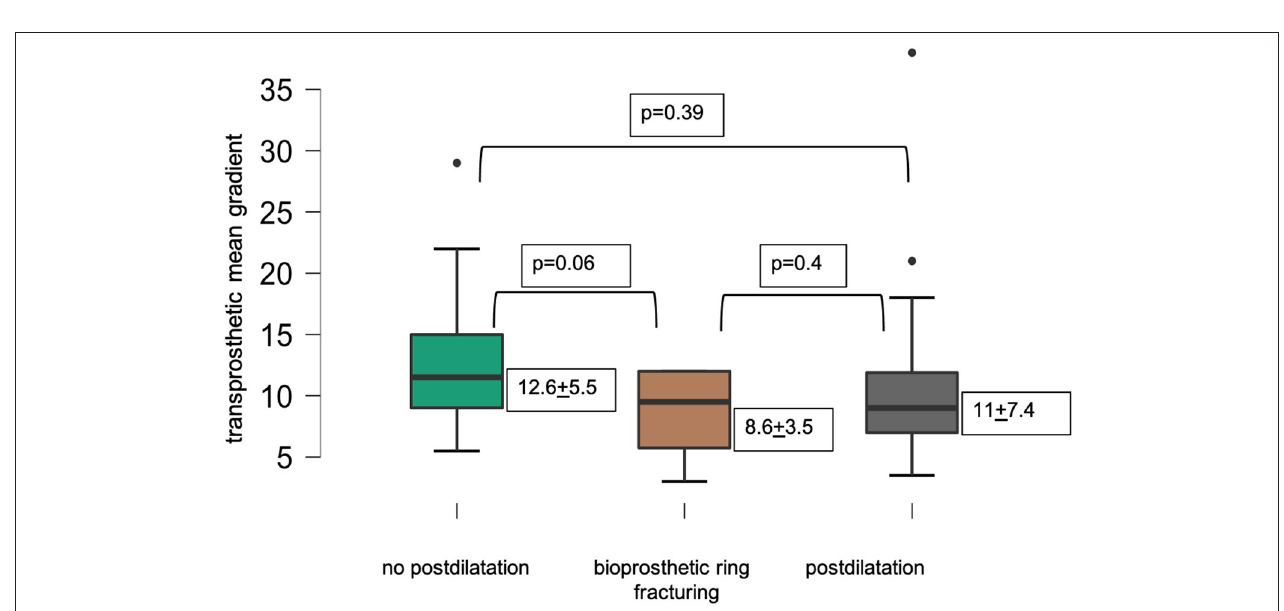
FIGURE 5 | Mean transprosthetic gradient after ViV-TAVR excluding patients with a balloon-expandable THV.